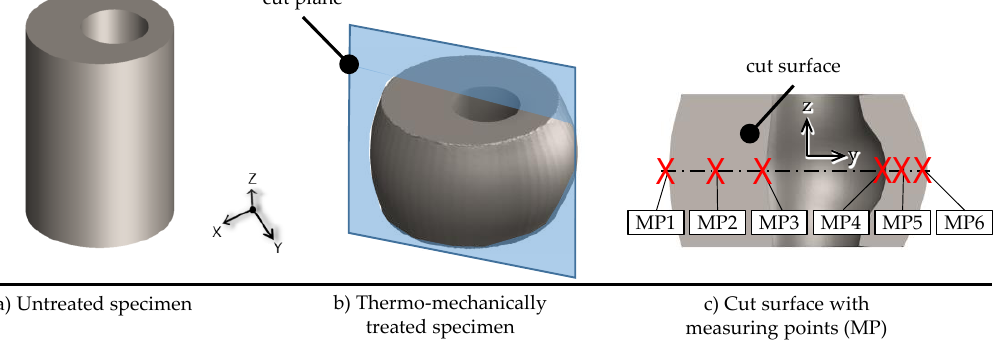
Figure 4. Illustration of the untreated ( a ) and the thermo-mechanically treated specimens ( b ), and the cut surface including measuring points MP1 to MP6 at the mid-height of the cut specimen ( c ).